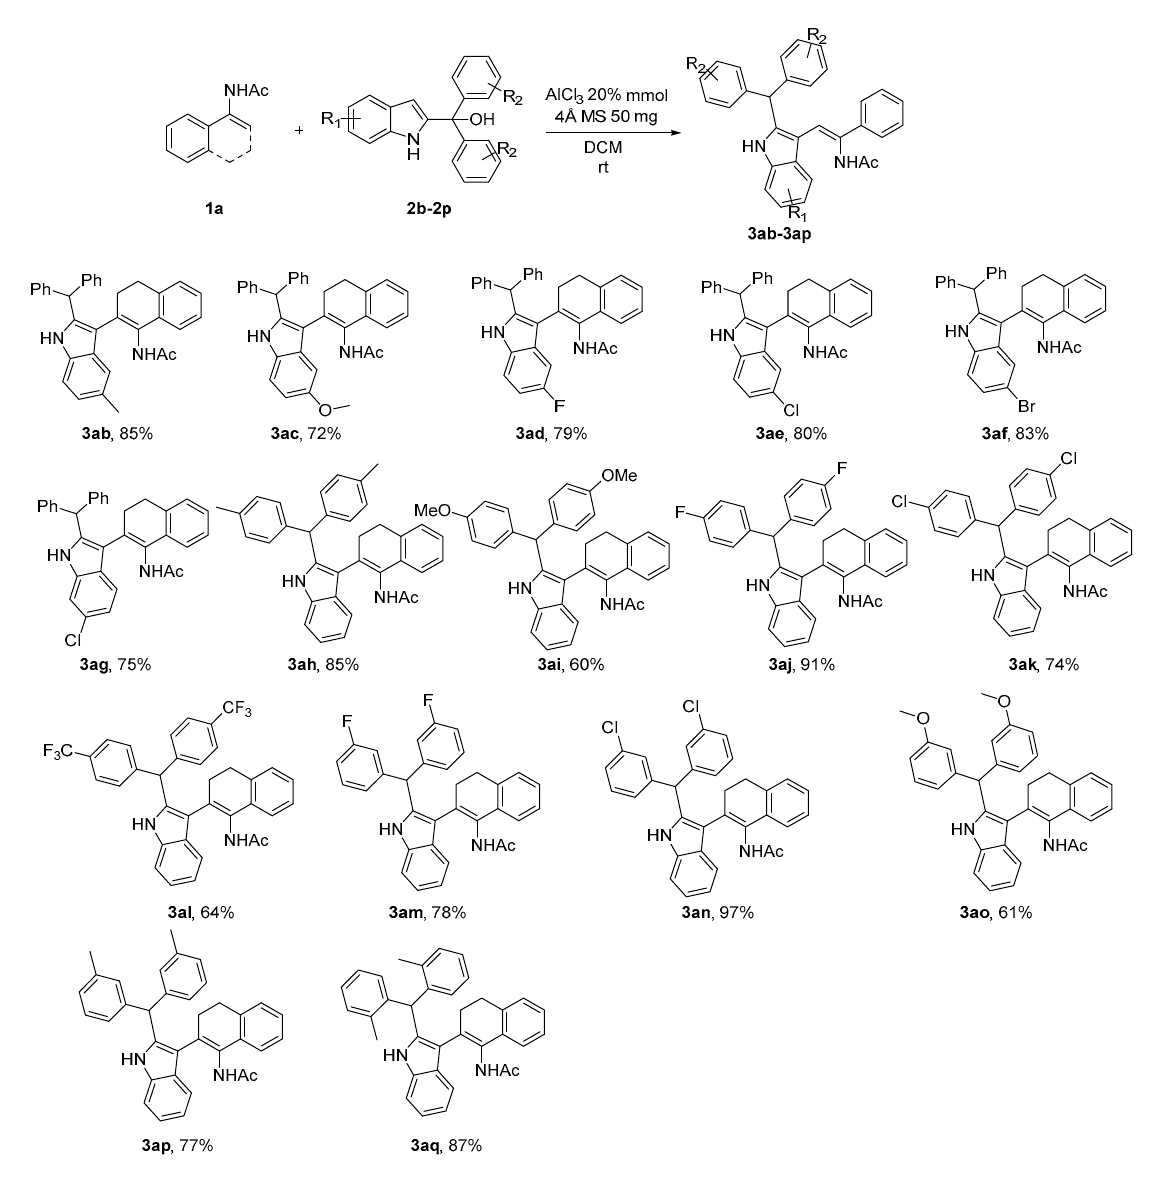
Figure 3. Scope of 2-indolemethanols.